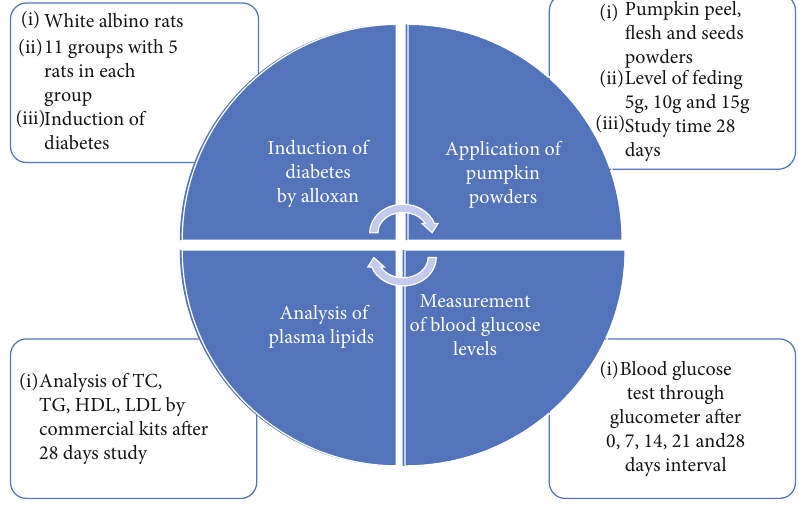
Figure 1: An overview of research work plan. Table 2: Antihyperglycemic activity parameters of pumpkin peel, fl esh, and seed powders. Group ∗ Means ( ± SE) of blood glucose level